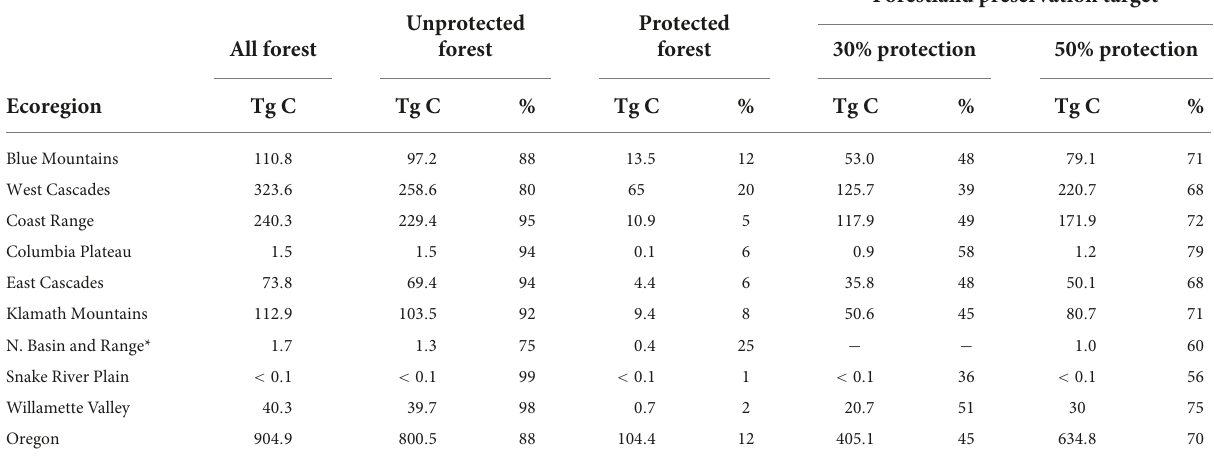
TABLE 3 Current tree aboveground carbon (AGC) stocks in each ecoregion’s forests, protected forests, and forests that would be protected by meeting preservation targets using joint prioritization.